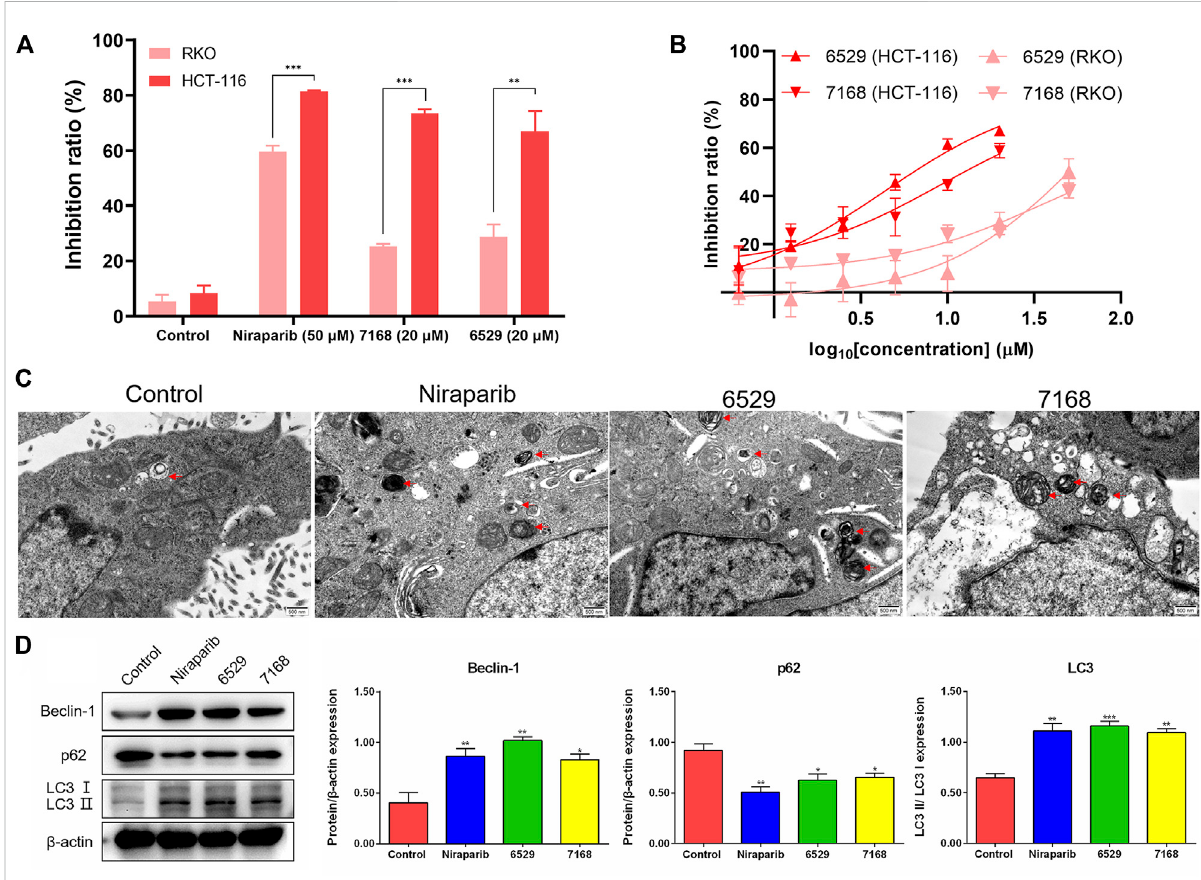
FIGURE 7 DiscoveredhitcompoundsinhibitcellsurvivalandinducedtheautophagyinahumancolorectalcarcinomacelllineHCT-116. (A) Theinhibition ratio of two hit compounds (8012-0567, 8018-7603) at 20 μ M against the cell survival of human colorectal carcinoma cell lines (HCT-116, RKO), Niraparibat50 μ Masthepositivecontrol.CellviabilitywasdeterminedbytheCCK-8assay( n =3).(* p < 0.05,** p < 0.01,*** p < 0.001) (B) thehuman colorectalcarcinomacelllines(HCT-116,RKO)weretreatedwithdifferentconcentrationsof8018-6529and8018-7168.TheIC50valueswere predicted byutilizingtheGraphPad ® program. (C) TEMdetection ofautophagosomesaccumulation inHCT-116 cellstreatedwithcompound8018- 6529 and 8018-7168 for 24 h, Niraparib as the positive control. (D) Western blot analysis was performed after treatment of compound 8018- 6529 and 8018-7168 to demonstrate the expression of Beclin-1, p62, and LC3 II/I protein, markers for autophagy, Niraparib as the positive control. Densitometric values of Beclin-1, p62 and LC3 compared with their respective total proteins were evaluated via ImageJ software and are presented as the mean ± SD ( n = 3) (* p < 0.05, ** p < 0.01, *** p < 0.001).